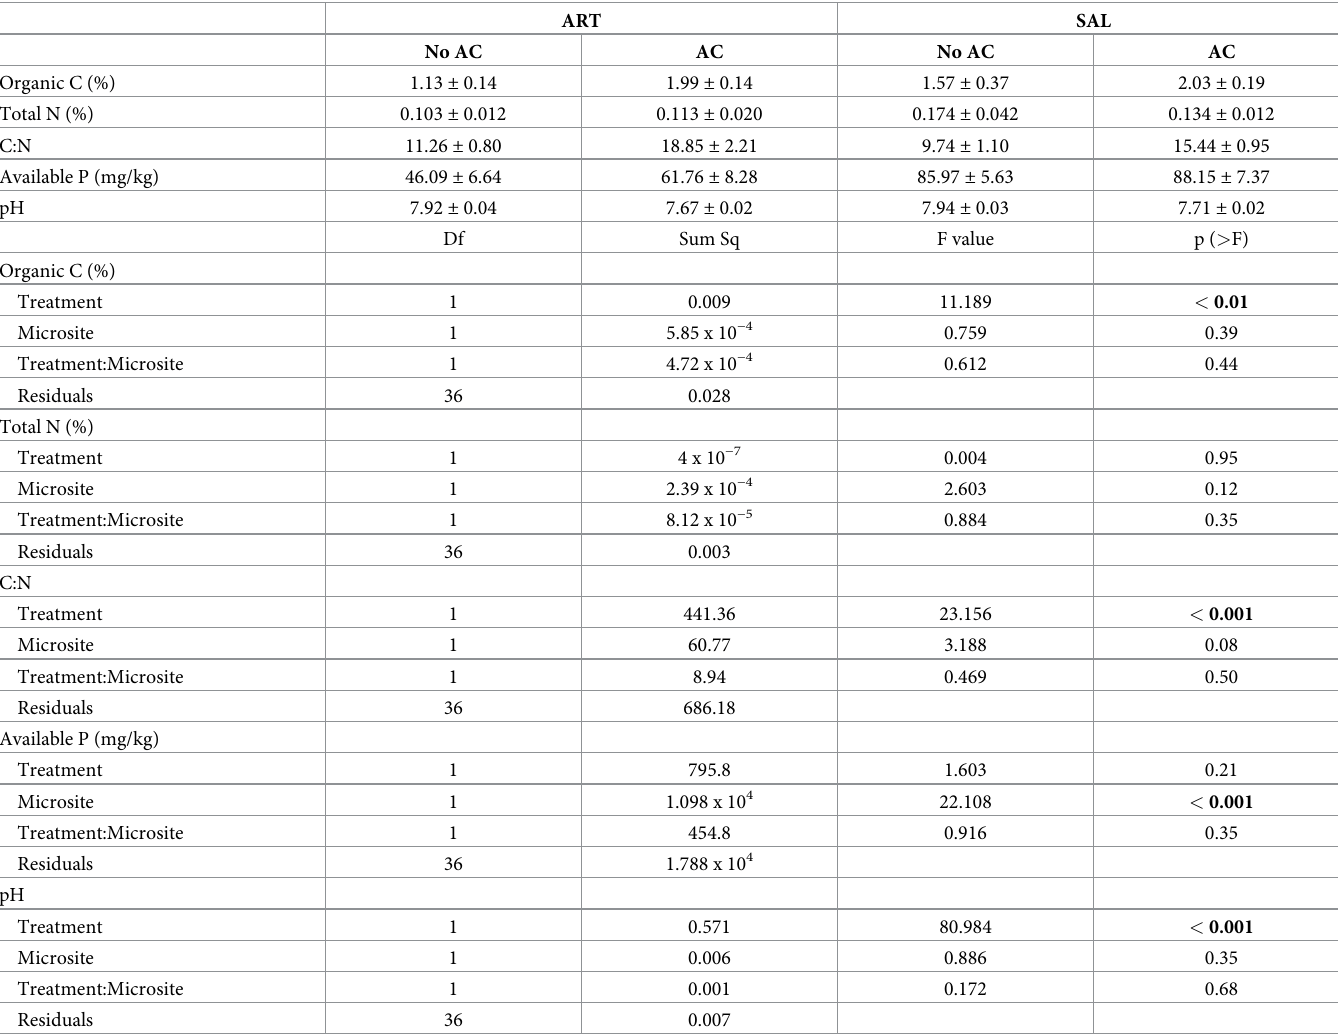
Table 3. Soil chemical characteristics (mean ± SE) and result of ANOVA analyses for the effect of treatment and microsite on those characteristics. ART